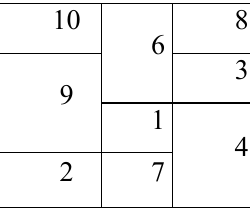
Fig. 1. Flexible bay structure representation of facilities in the